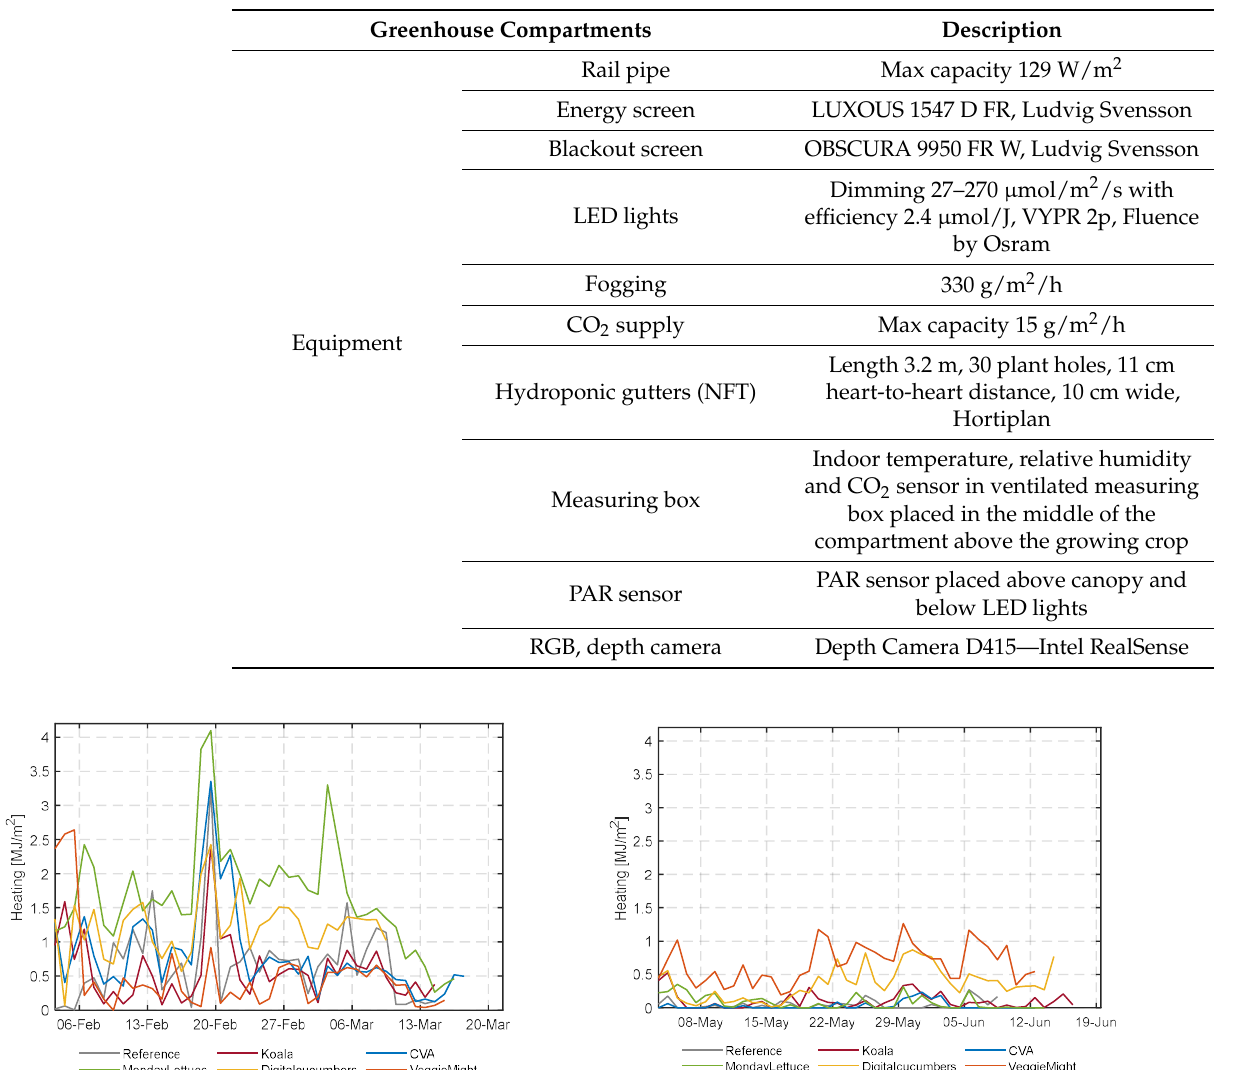
Figure A1. Heating energy consumption (MJ/m 2 ) of all compartments during the first and second cultivation.